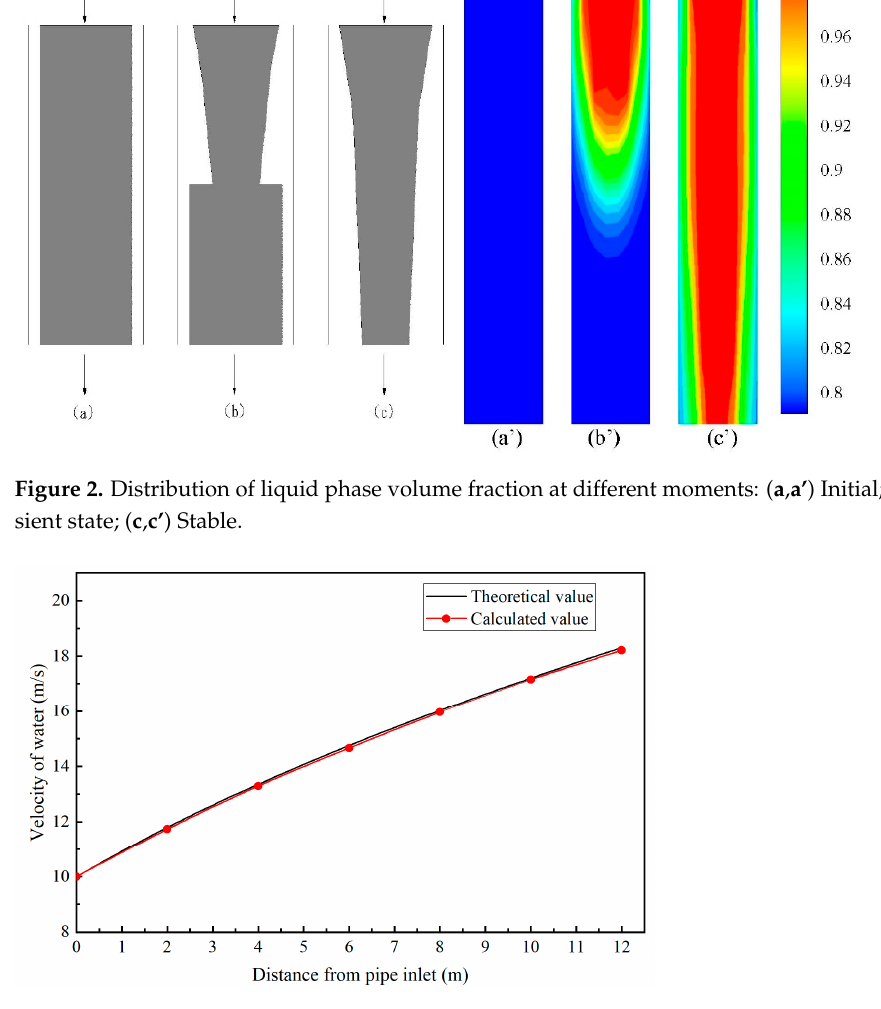
Figure 3. Comparison between theoretical value and calculated value of water velocity at different distances from pipeline inlet.